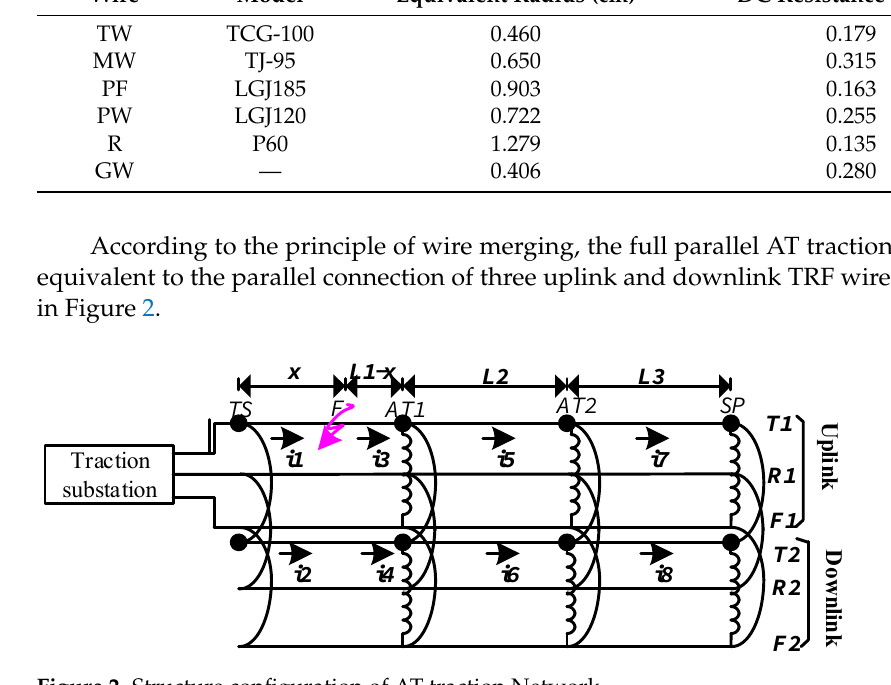
Figure 2. Structure configuration of AT traction Network.